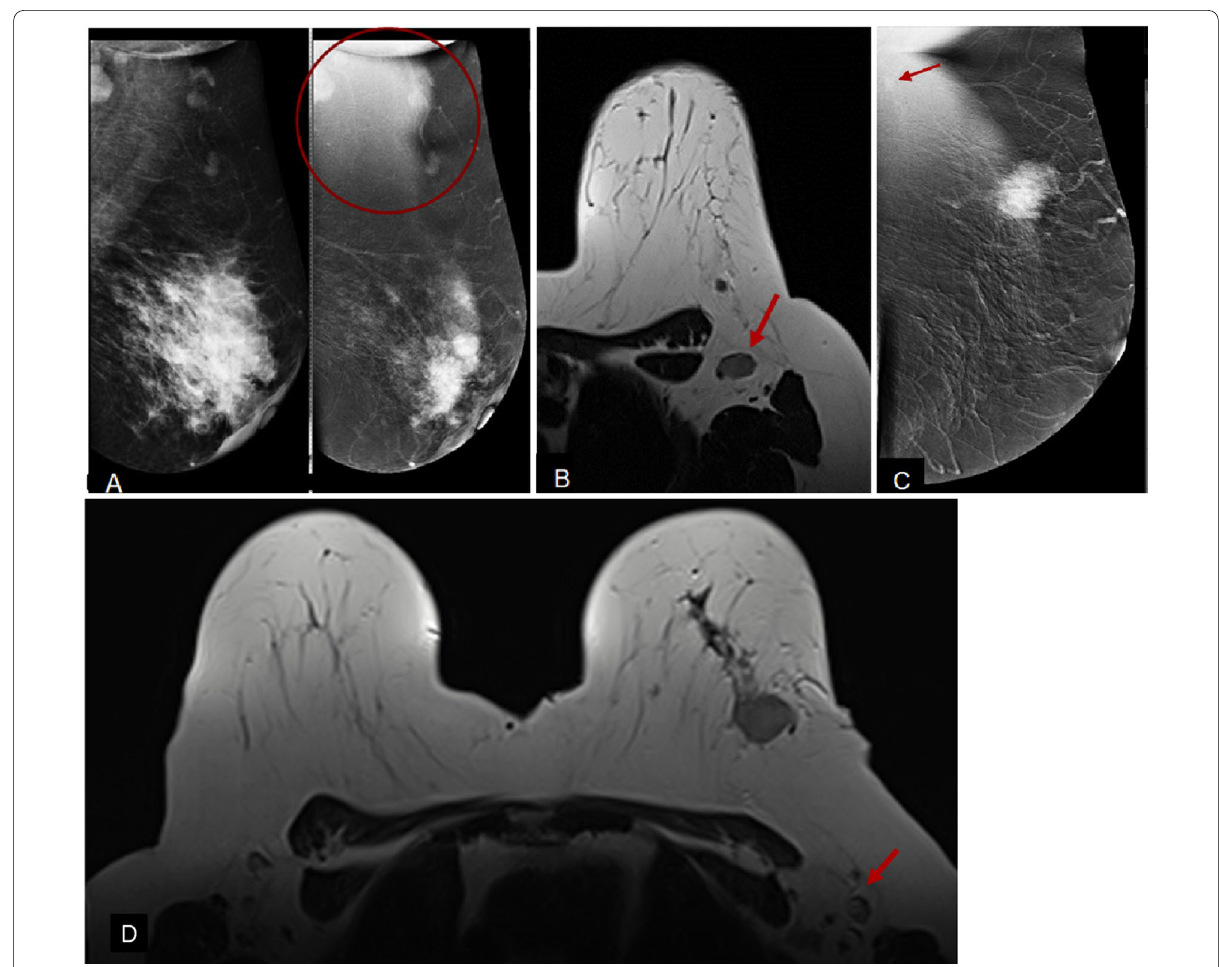
Fig. 6 Two different cases of primary breast carcinomas, (case 1 A and B, case 2 C and D). Digital mammograms and CEM medio-lateral views of breast carcinomas ( a , c ), the lymph nodes are noted at the mammograms (circles in ( a ) and arrow in ( c )) but their differentiation are not clear on basis of the mammogram. On MR images ( b , d ), the malignant axillary node (arrow in B) could be easily discriminated from the benign one (arrow in d